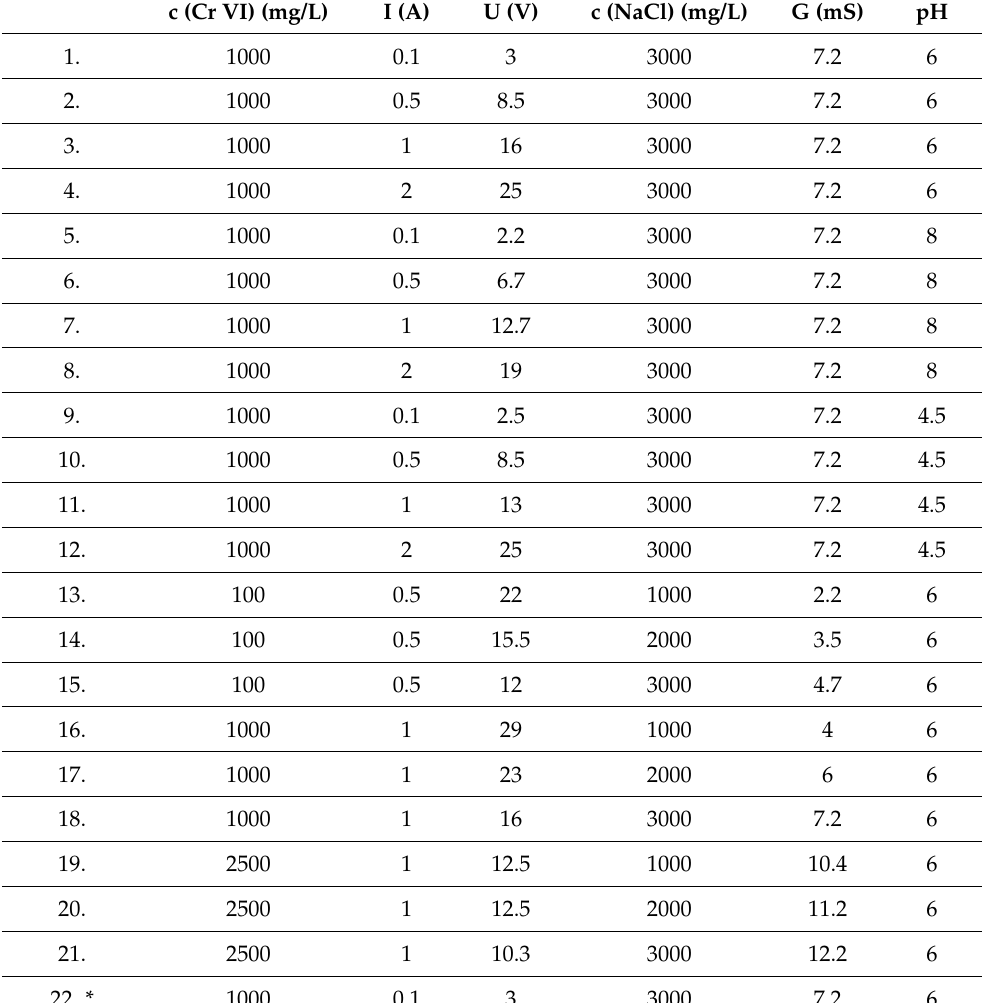
Table 1. Investigated model solutions experimental